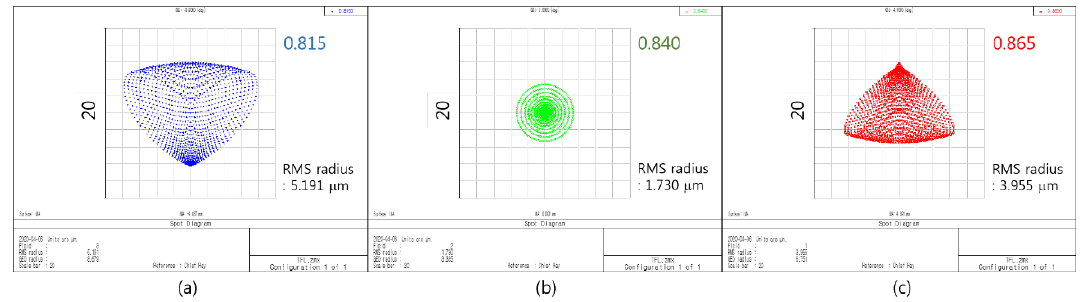
Figure 6. The modulation transfer function ( MTF) curve for ( a ) the ADL and ( b ) the TFL at three incident angles of 0 degrees, −3 degrees, and 4 degrees corresponding to three wavelengths of 815 nm, 840 nm, 865 nm, respectively. 3. Experimental Setup The light source used in the experiment was SLED (EXS210090-01, EXALOS), which had a central wavelength of 840 nm, a spectral bandwidth of 50 nm, and an output power of 12 mW. The light beam from the light source was directed to a 2 × 2 fiber optic coupler that acts as fiber-optic Michelson interferometer and is split into a reference and sample arm. The sample arm consists of a fiber-optic collimator (F810APC-842, THORLABS), an achromatic doublet lens (AC254-040-B-ML, THORLABS) and a 2-axis Galvano-scanner to perform lateral scanning over a sample. The same devices, except for the 2-axis Galvano-scanner, were used in the reference arm to match the dispersion balance. The reflected light beams from both arms were recoupled to the fiber-optic collimator and generated interference signals depending on the OPD between two arms. The interference signal is propagated through single-mode fiber to a spectrometer, where the interference signal of 2048 data points was recorded by a high-speed frame grabber (NI PCI-e 1433, NATIONAL INSTRUMENTS) as a function of the spectral components of the SLD. After removing background noise and applying the Hanning window, the spectral signal was subjected to k-linearization to convert it as a function of wavenumber. For k-linearization, a wavenumber mapping table for each wavelength was prepared prior to the experiment using five fiber Bragg gratings. The interference signal after k- linearization was subjected to a discrete Fourier transform. OCT images were reconstructed by mapping Fourier transformed 1024 data on a grayscale. A program developed using LABVIEW was used for the system operation and signal processing.